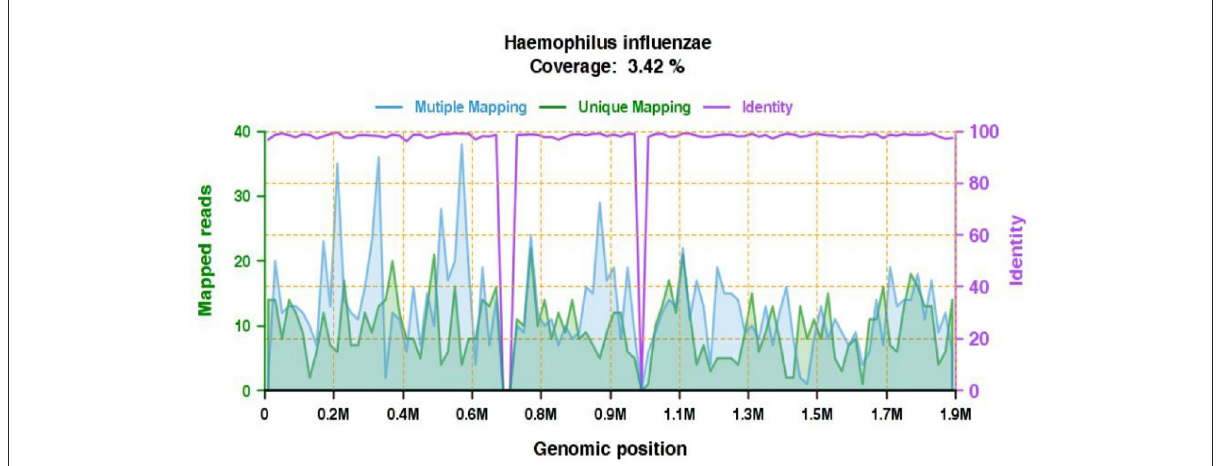
FIGURE1 High confidence pathogen genome coverage map: gene coverage map of H. influenzae . The total number of bases in the genome of this species is 1,890,645 (bp) and the total length of the measured sequence coverage of this species is 64,657 (bp), with a coverage of 3.42% and an average depth of 1.07553706481897X.